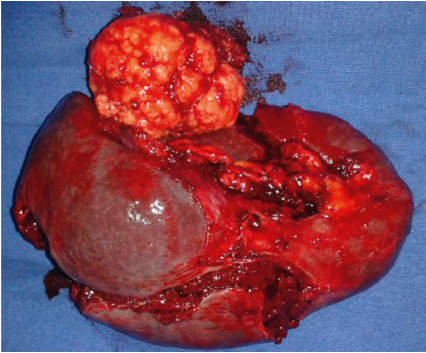
Figure 1: Necrotic tumor in the upper pole of the spleen.